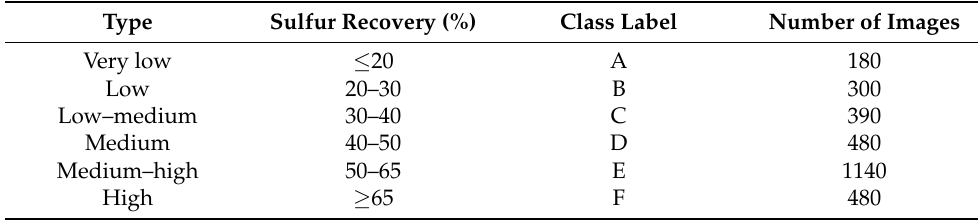
Table 4. Different froth classes in CNN model under various operating